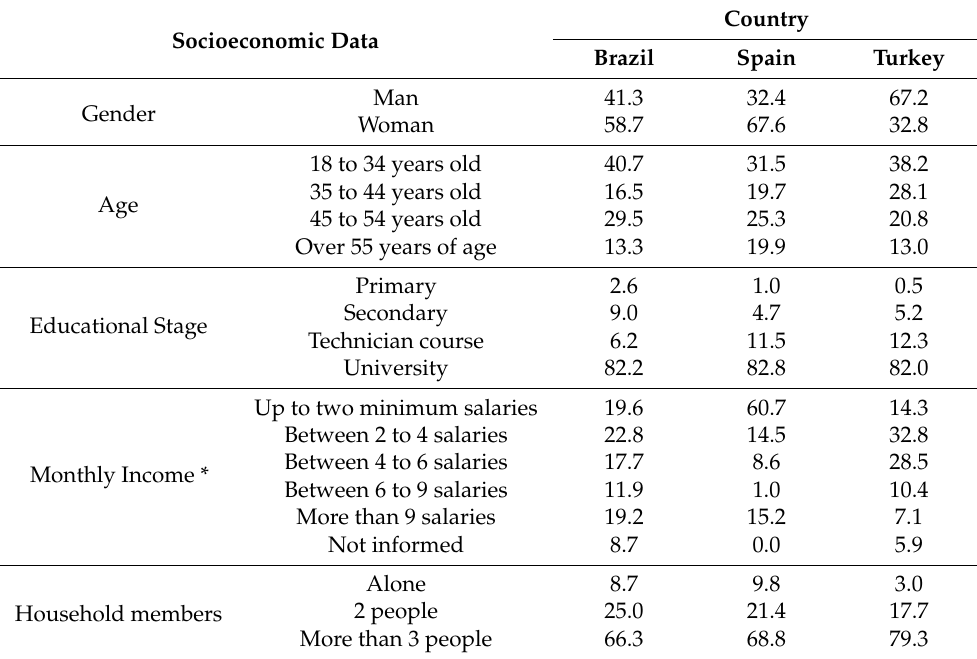
Table 2. Frequency of sociodemographic data in percent for gender, age, educational level, income, and family members of consumers studied in Brazil, Spain, and